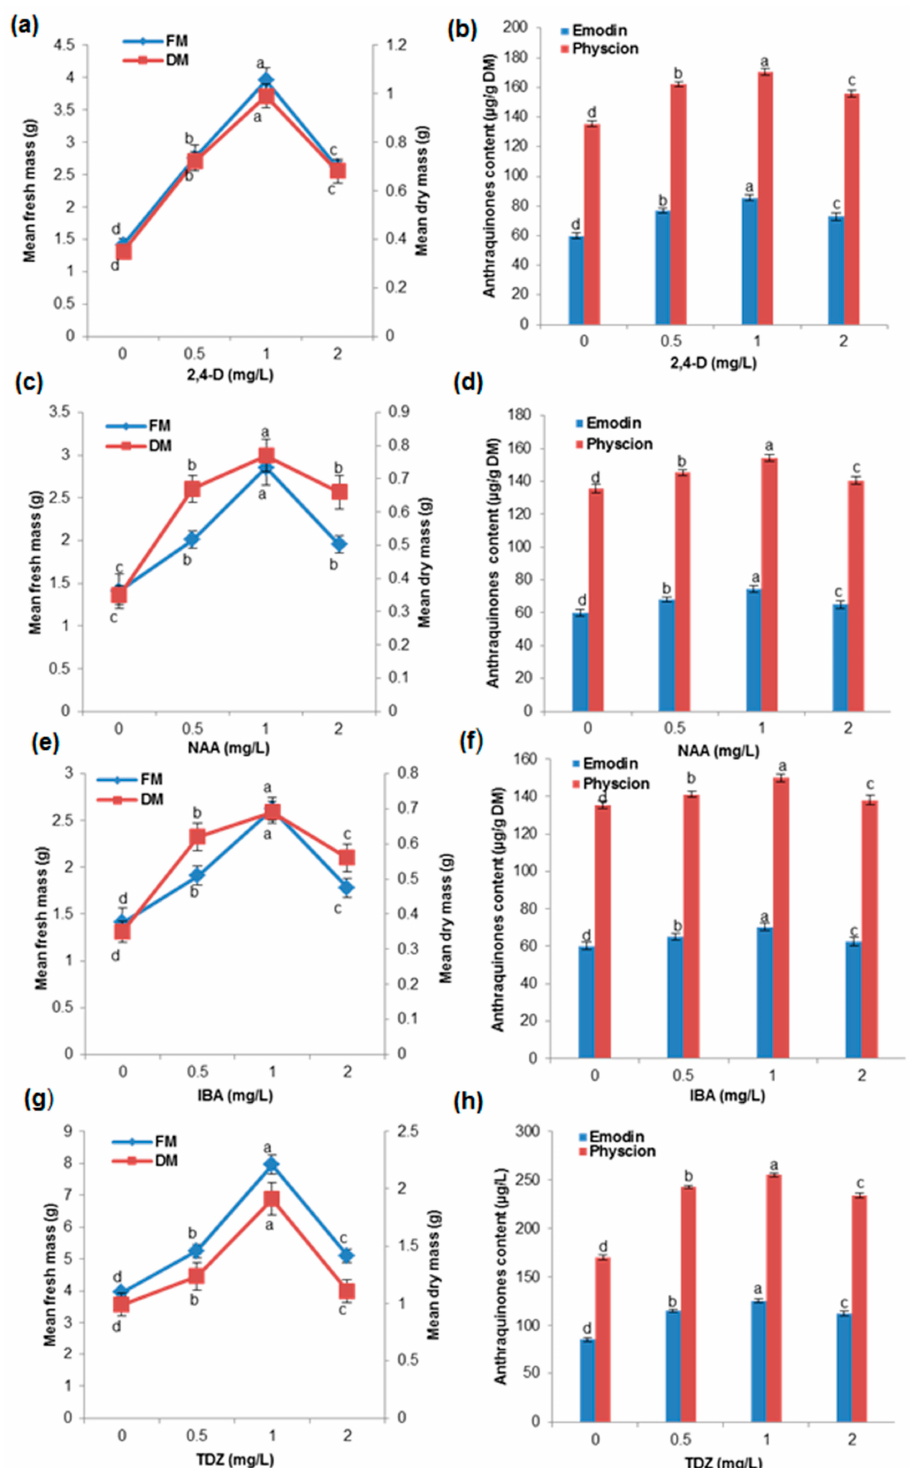
Figure 1. Effects of different concentrations of auxins and cytokinins in combination with biomass accumulation and anthraquinone (emodin and physcion) production in cell suspension cultures of P. multiflorum ; ( a , b ) 2,4-dichlorophenoxyacetic acid (2,4-D); ( c , d ) naphthaleneacetic acid (NAA); ( e , f ) indole-3-butyric acid (IBA); ( g , h ) 2,4-D 1.0 mg/L with thidiazuron (TDZ). Means ± standard deviation of three replicates followed by the same letters are not significantly different according to Duncan’s multiple range test (DMRT) at p ≤ 0.05. DM: dry mass; FM: fresh mass.